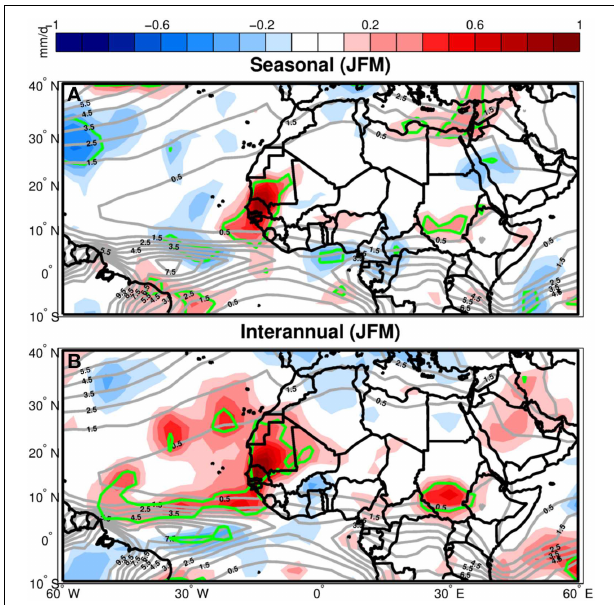
FIGURE 3 | Spatial regression (in mm/day) in winter (JFM) between Saloum rainfall and rainfall over the rest of the domain for (A) Seasonal, (B) Interannual time scale. Green contours delimit areas where the regression is significant at 95% level using a Monte Carlo simulation. Gray contours represent the mean (JFM) climatological rainfall (mm/d).